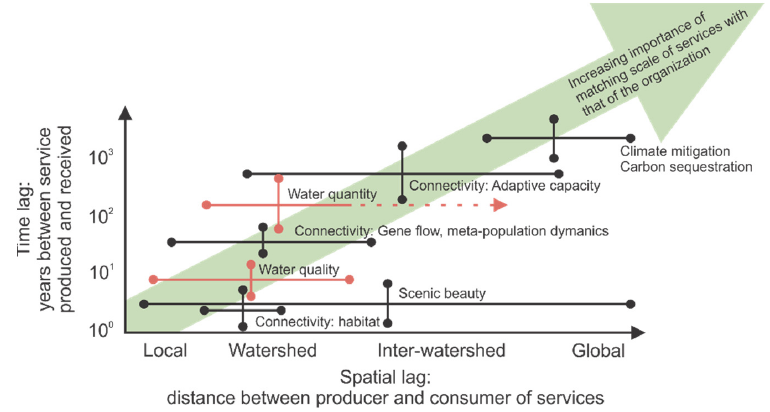
Figure 4. Forest aquatic ecosystem services affect people long after and far from where forest management decisions are made. The vertical axis shows the time lag in terms of multi-decadal recovery, and scale of impacts ranging from local to national and global. Modified from [44].